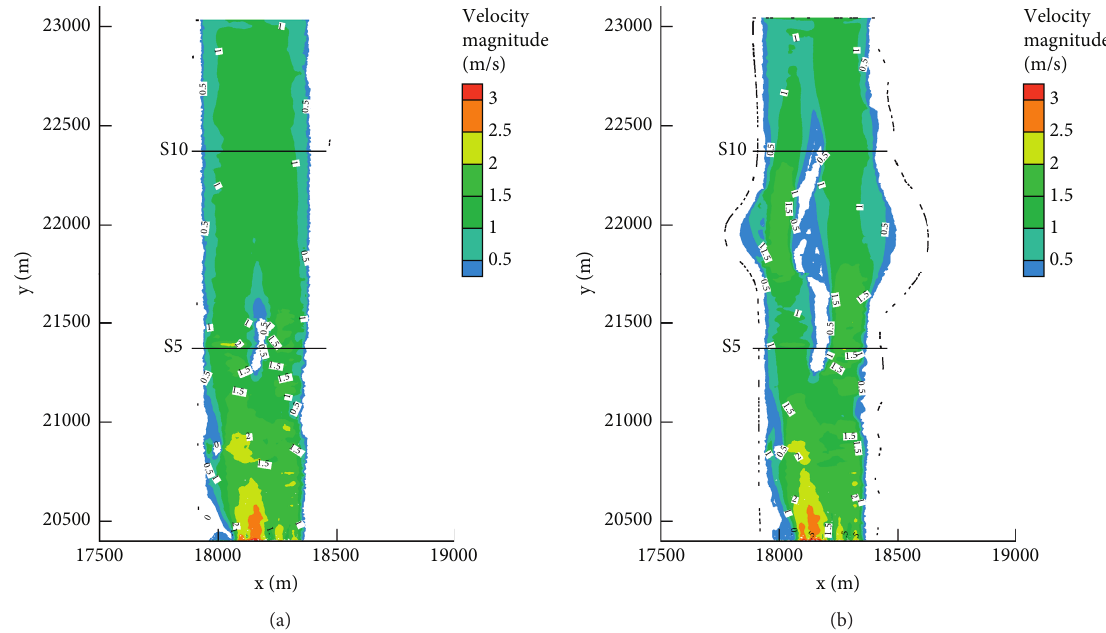
Figure 7: Comparisons of the velocity of flood flow before and after river reconstruction for a 10-year flood. (a) Before reconstruction. (b) After